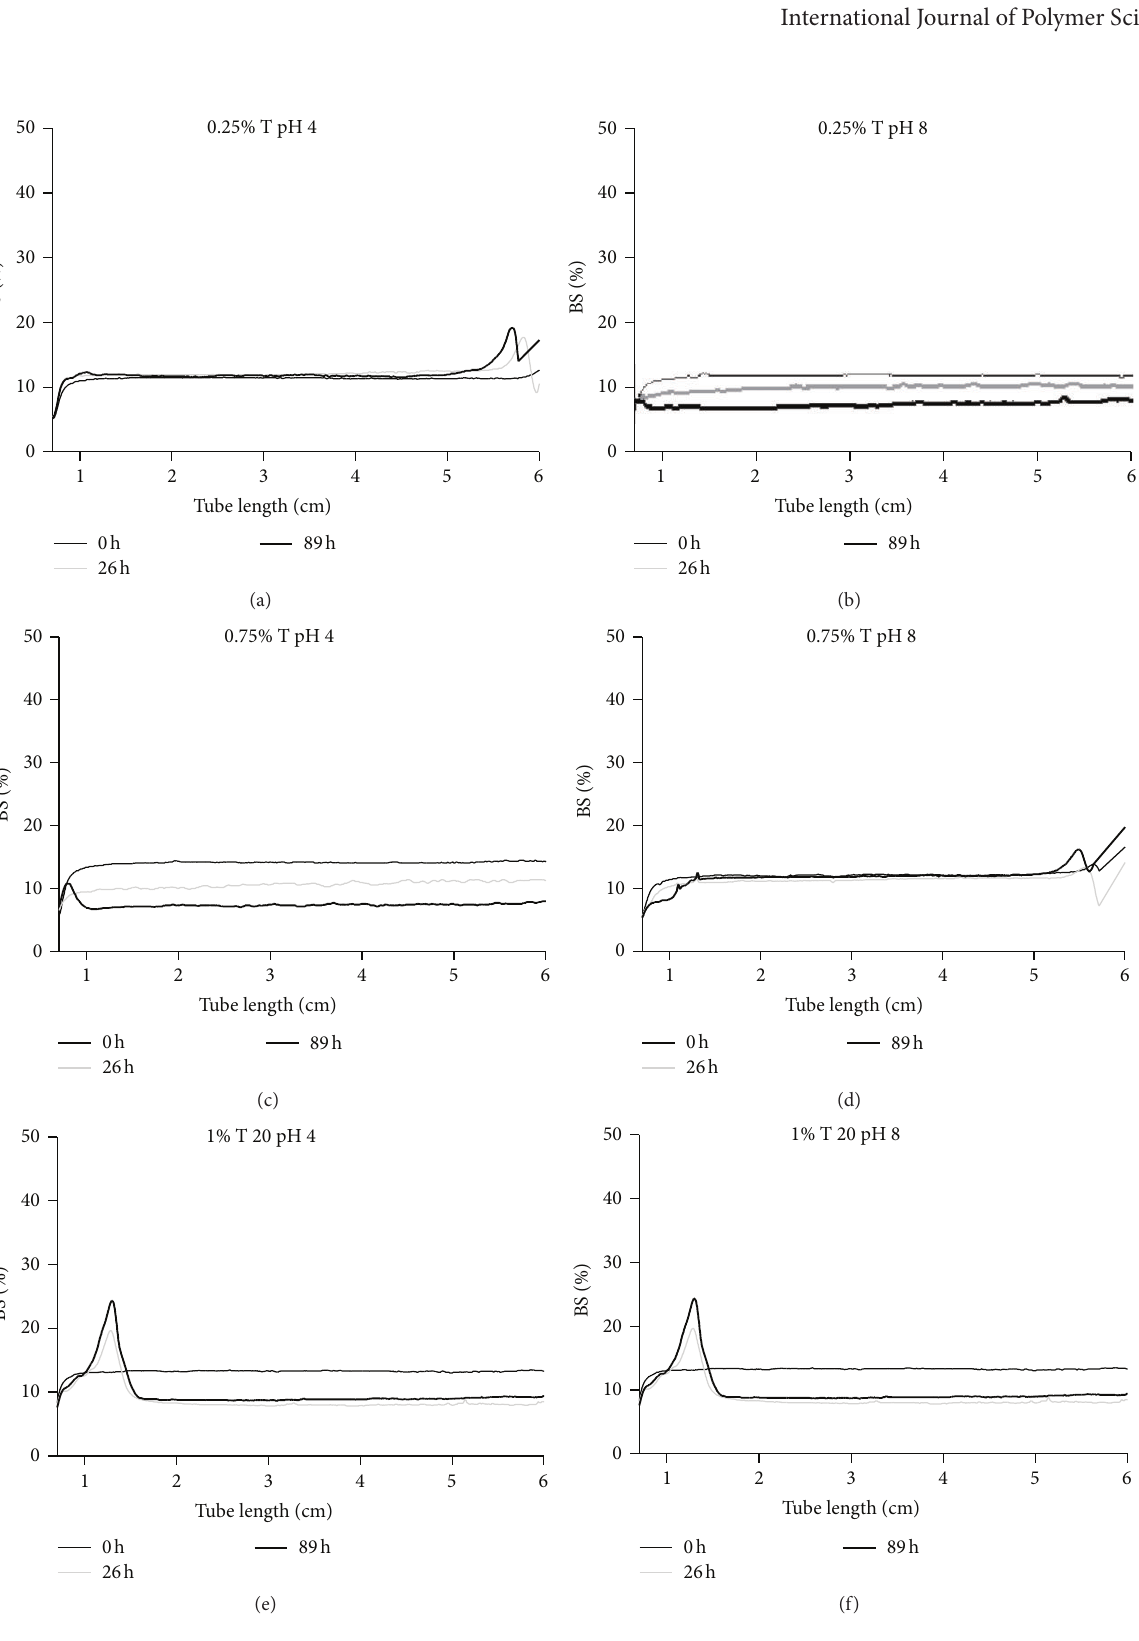
Figure 1: Stability of the emulsions stored at 40 ∘ C, comparing final pH of the emulsion and the type-concentration of the encapsulating agents. 0.25% T: 0.25% w/w trehalose; 0.75% T: 0.75% w/w trehalose; T 20: 1%w/w Tween